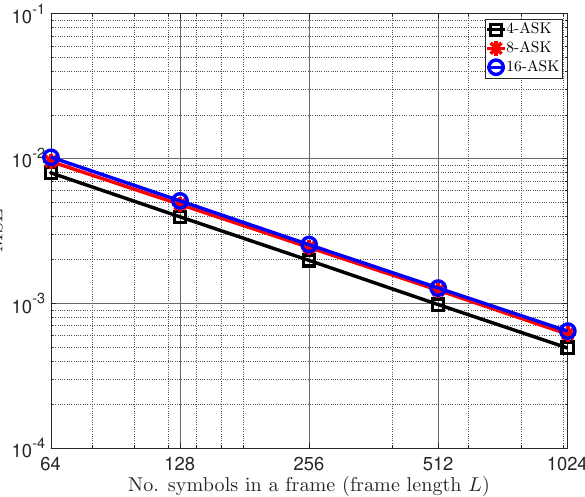
Figure 4. Average MSE of the proposed BEE algorithm with respect to the frame length, when the transmit SNRs of both STAs are ρ 1 = ρ 2 = 30